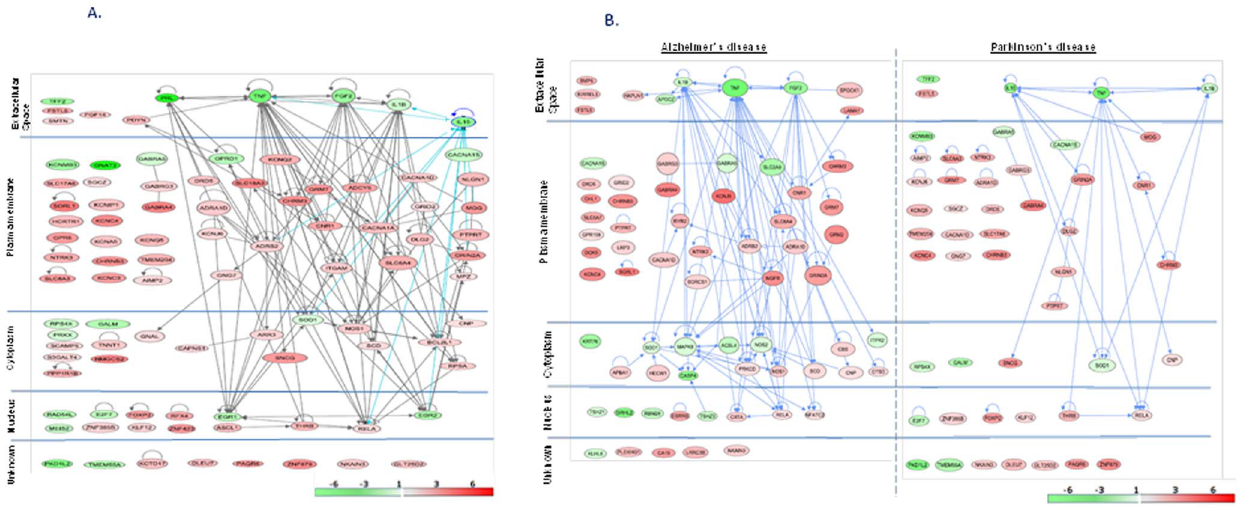
Figure 2. Regulatory networks showing the clusters of differentially regulated genes involved in ‘‘neurological diseases’’. The nodes represent the genes and the solid lines depict the interactions between two molecules. Red- and green-colored genes show significantly increased and decreased expression (log 1.5 (FD-/SD-fed mice) in the FD-fed mice compared to the SD-fed mice (a color scale is at the bottom right corner). The genes are clustered based on their proteins’ cellular locations in the nucleus, cytoplasm, plasma membrane and extracellular space. The genes without the location information are grouped under ‘unknown’. Figure 2A depicts ‘‘movement disorder’’, the most enriched disease enlisting 70 genes with p =8.13 6 10 2 4 . Figure 2B depicts two additional diseases frequently linked with n-3 PUFA diets. Alzheimer’s disease (left panel) and Parkinson’s disease (right panel) enlist 70 and 50 genes with p values of 1.11 6 10 2 3 and 1.26 6 10 2 3 , respectively.